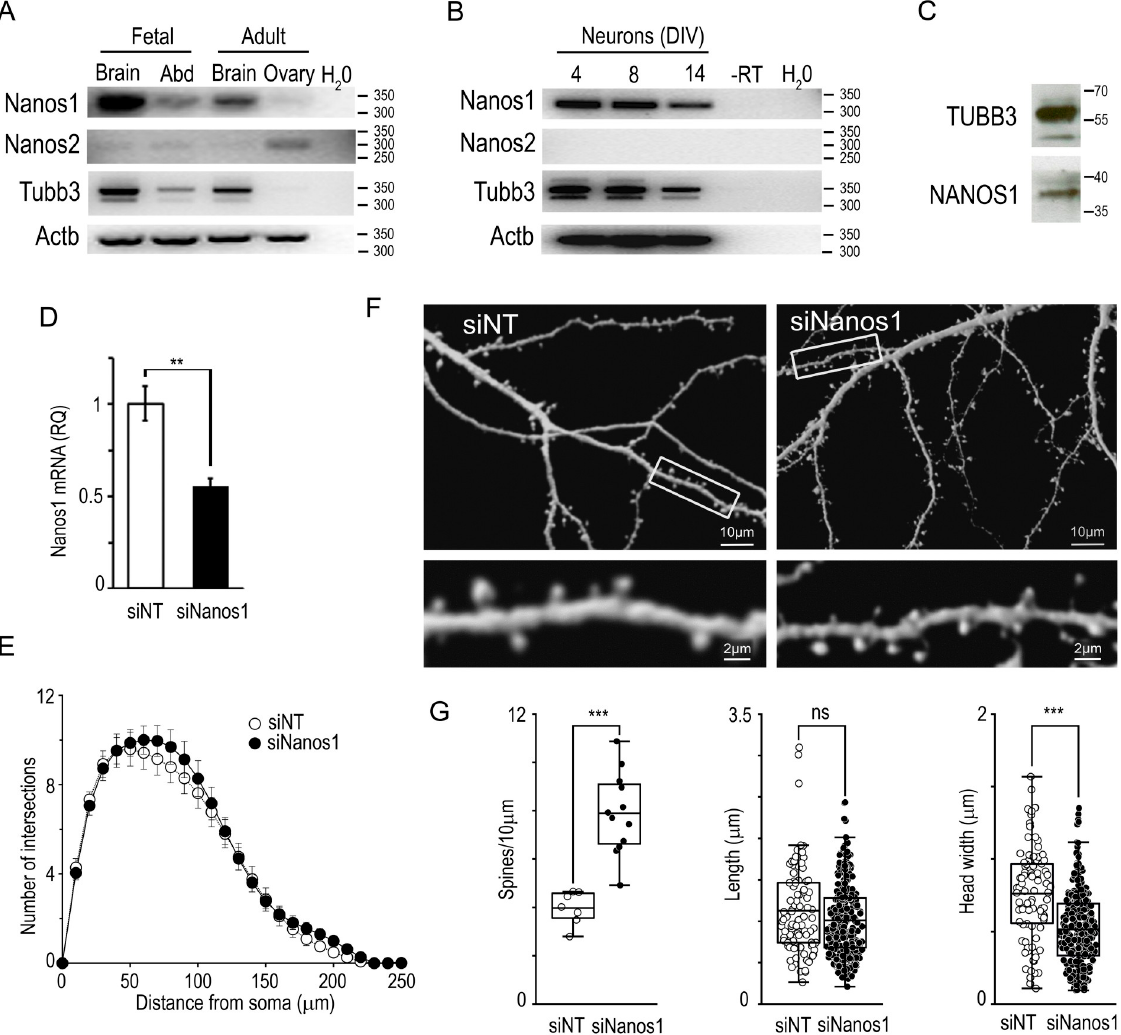
Fig 1. Nanos1 knockdown affects dendritic spines. (A, B) Nanos1 expression in rat tissues (A) and cultured hippocampal neurons (B). RT-PCR for Nanos1 , Nanos2 , Tubb3 , or Actb was performed, and PCR products were analyzed in agarose gels. A representative experiment out of three is shown. Days in vitro (DIV) are indicated. (C) Protein extracts from 14-DIV cultured neurons were analyzed by western blot for the indicated proteins. (D) Cultured hippocampal neurons were allowed to differentiate for 7 days and then exposed to a pool of four siRNA against Nanos1 (siNanos1) or a non-targeting siRNA (siNT) as indicated in Materials and Methods. Nanos1 mRNA levels normalized to Actb mRNA levels were analyzed at 14 DIV by quantitative RT-PCR. Error bars, standard deviation from triplicate RT-PCRs, ** p < 0.05, Student’s t-test. (E-G) pECFP-N1 was transfected one day after plating and then neurons were treated with the indicated siRNAs as in (D). (E) Dendritic arborization was evaluated by Sholl analysis as indicated in Materials and Methods in 26 siNT and 31 siNanos1-treated cells from six independent cultures. A t-test was performed for each step. (F) Representative dendrite fragments are shown in each case. (G) The number of dendritic spines, their length, and the maximum diameter of the spine heads were determined in three independent experiments (siNT: 91 spines from 7 neurons; siNanos1: 271 spines, 12 neurons), ** p < 0.01; *** p < 0.001, Student’s t-test (Error bars, standard error).